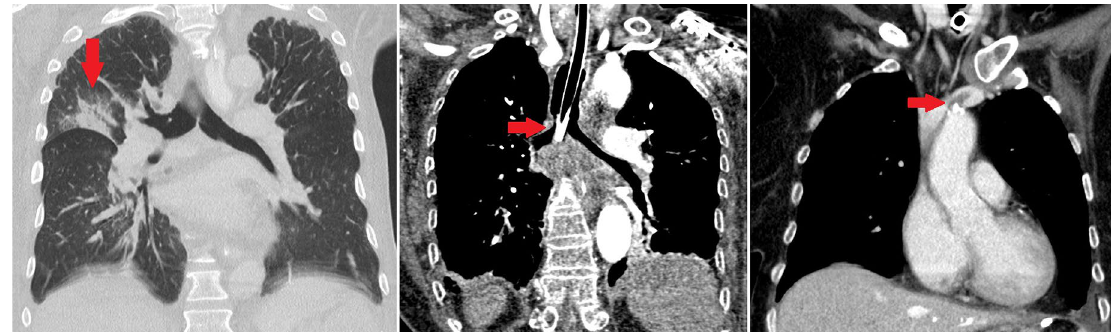
Fig. 5 Examples of imaging findings on thoracic CT above the diaphragmatic dome. Left: Coronal contrast enhanced CT showing pneumonic infiltrate in the right upper lobe. Middle: Coronal contrast enhanced CT showing endotracheal tube malposition in the right main bronchus. Right: Coronal contrast enhanced CT showing catheter‑associated thrombosis in the left brachiocephalic